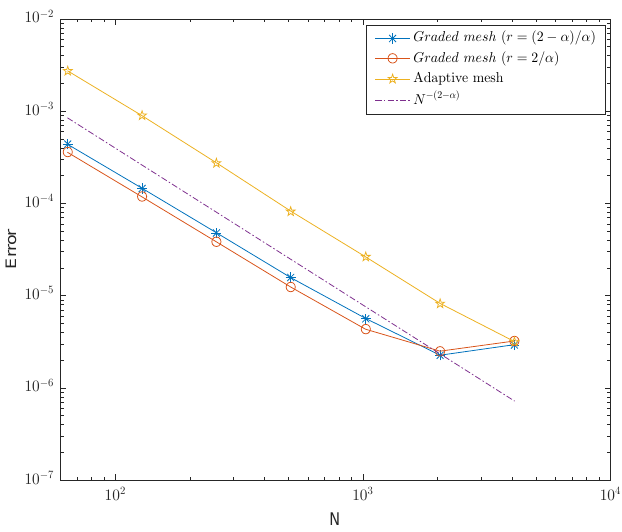
Figure 3. Convergence orders of adaptive grid and graded grids with α = 0.3.